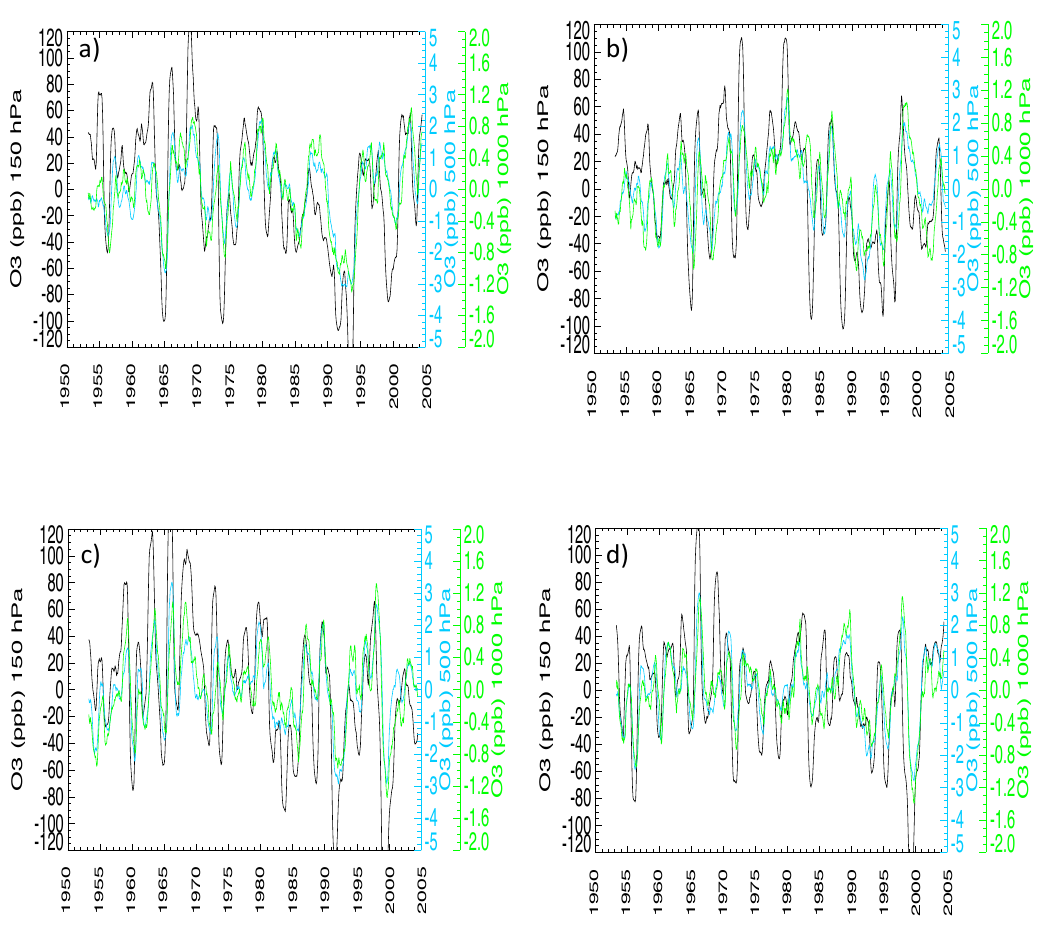
Figure 10. Ozone deviations (ppb) averaged from 30 to 90 ◦ N for each of the four WACCM ensemble members at 150hPa (black), 500hPa (blue) and the surface (green). The linear dependence on global methane has been removed from the ozone records at 500 and 1000hPa. Monthly ozone deviations are smoothed over 12 months. Deviations are from ozone averaged over the entire simulation. Note the different scales for each